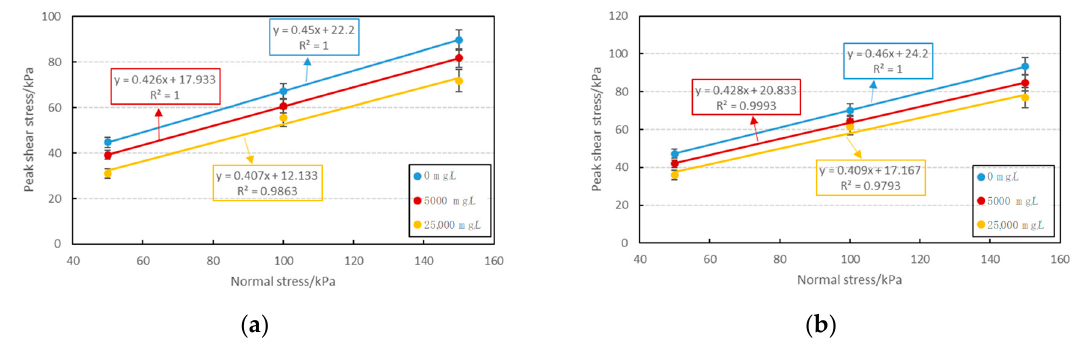
Figure 10. Plots of peak shear stress vs. normal stress for the 1-day old FR-CPB / rock interface specimens